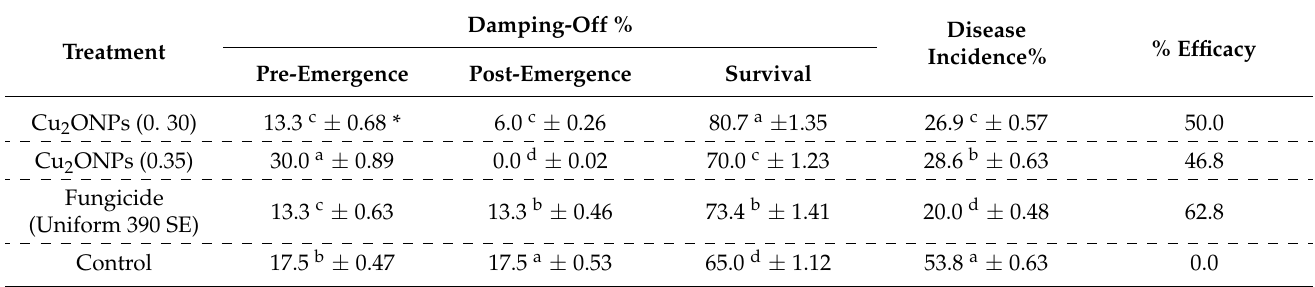
Table 3. Effect of Cu 2 ONPs compared to the chemical fungicide on the percentages of damping-off and root rot disease incidence of F. solani in cucumber plants under greenhouse conditions.